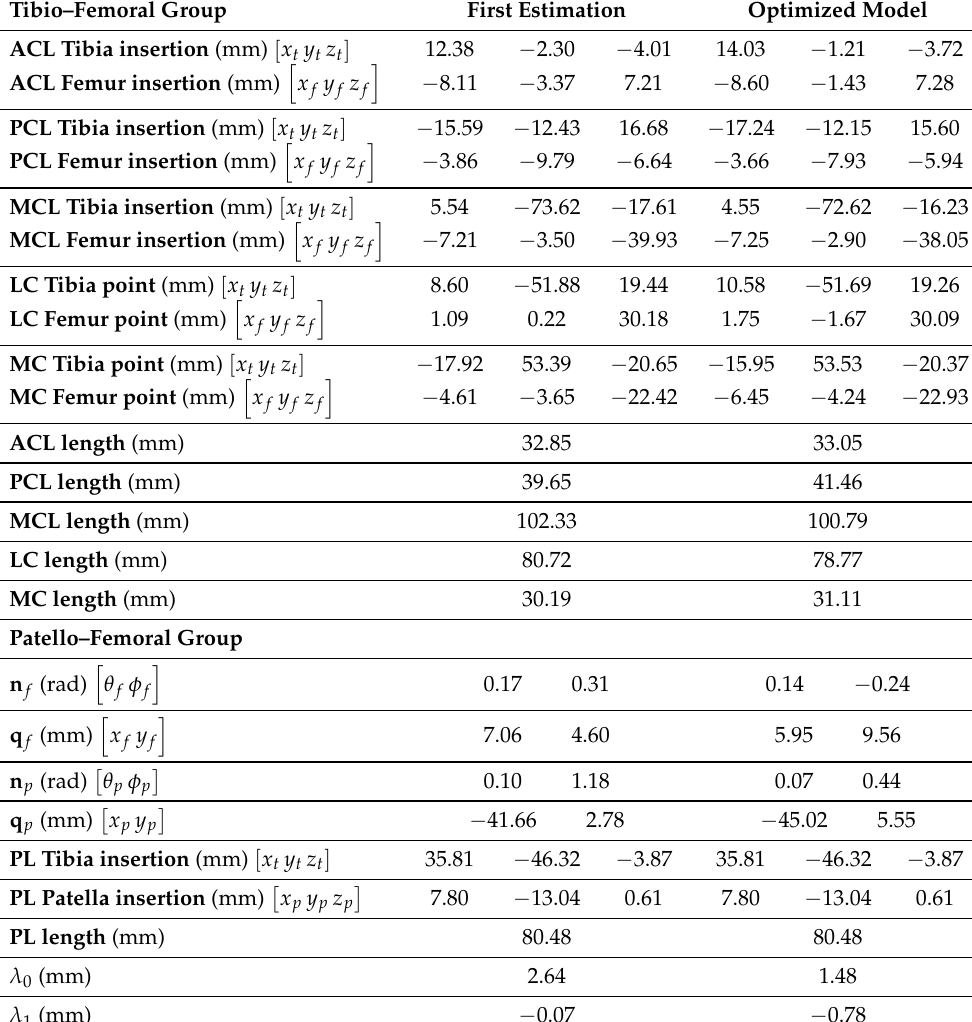
Table 1. The geometry of the subject-specific model as directly identified from the medical imaging data (i.e., the first estimation) and after optimization (i.e., the optimized model). Points are represented in the reference system of the corresponding bone. q f and q p are the intersection points between the patella axis and the sagittal plane, thus z = 0 for both vectors, n f and n p are parametrized by two angles θ k and φ k ( k = f , p ) : n k = [ cos ( φ k ) sin ( θ k ) sin ( φ k ) sin ( θ k ) cos ( θ k )] T ([14]). First